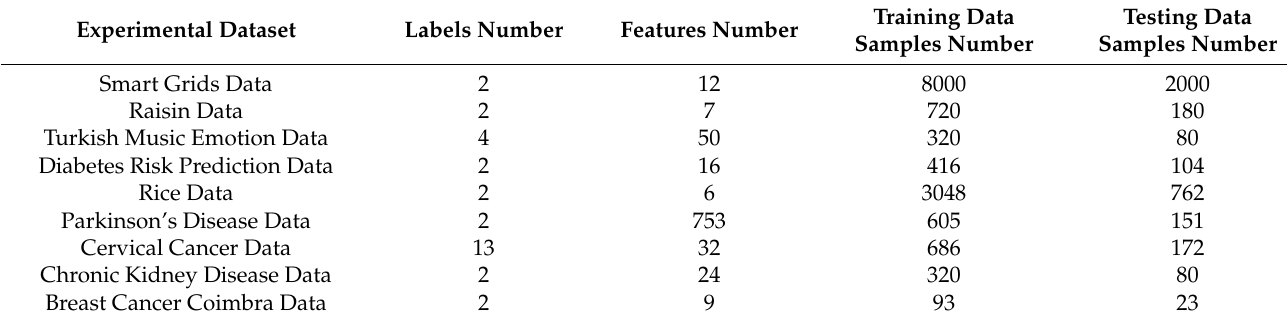
Table 2. Experimental Datasets Summary.